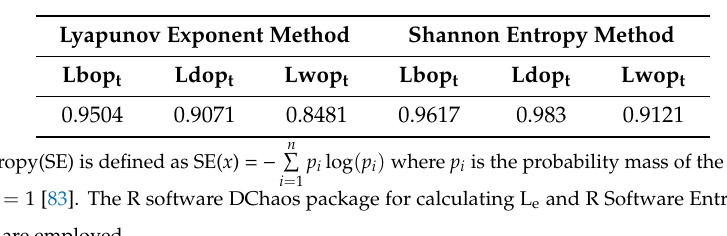
Table 3. TsaytestandHsieh’scoefficients. r ij ’sareHsieh’s[81]third-ordermomentcoefficients. Hsieh’s[81] third-order moment coefficients were obtained as